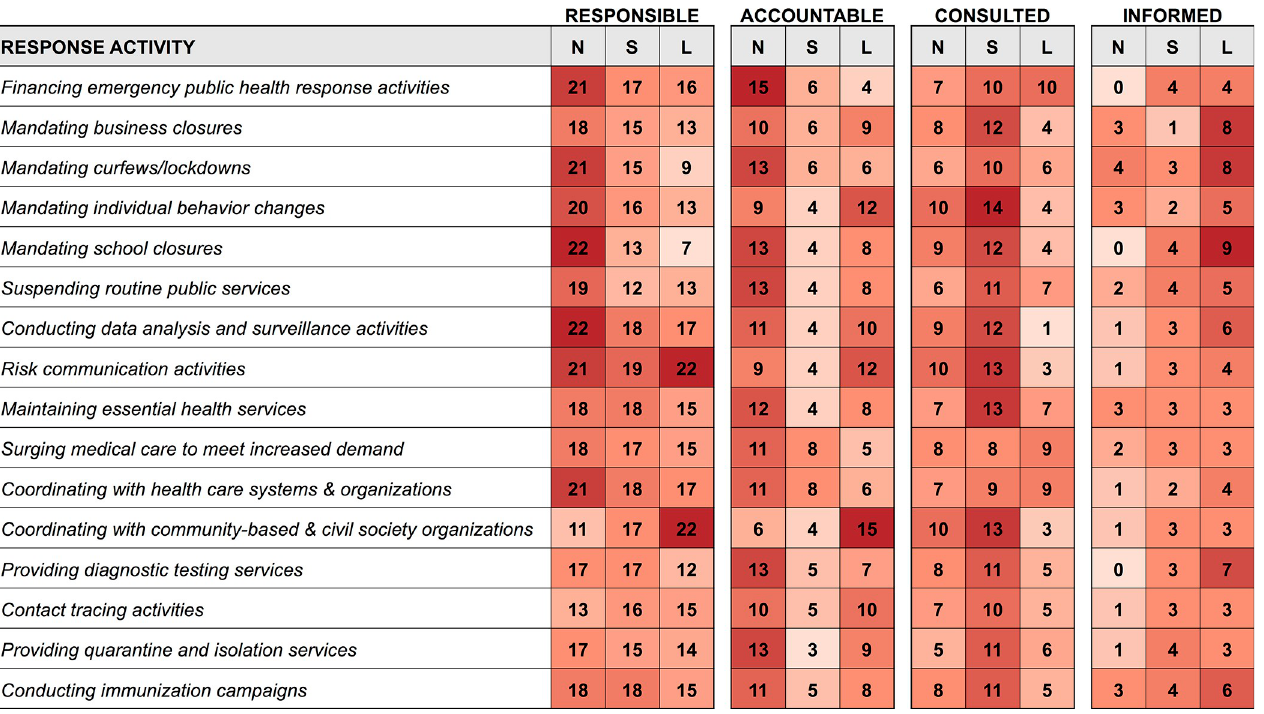
Fig 2. Heat maps displaying which levels of government are responsible, accountable, accounted, and informed for select pandemic response activities in cities according to survey responses (n = 25). One city indicated that no level of government was accountable for maintaining essential health services, surging medical care to meet increased demand, or conducting immunization campaigns; N–National, S–Subnational, L–Local.